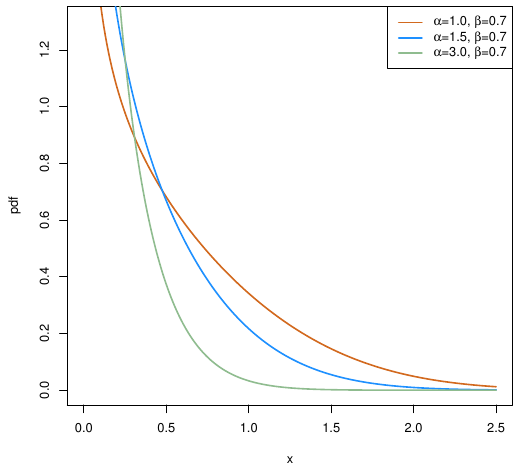
Figure 2. The pdf when α ≥ 1, 0 < β < 1.